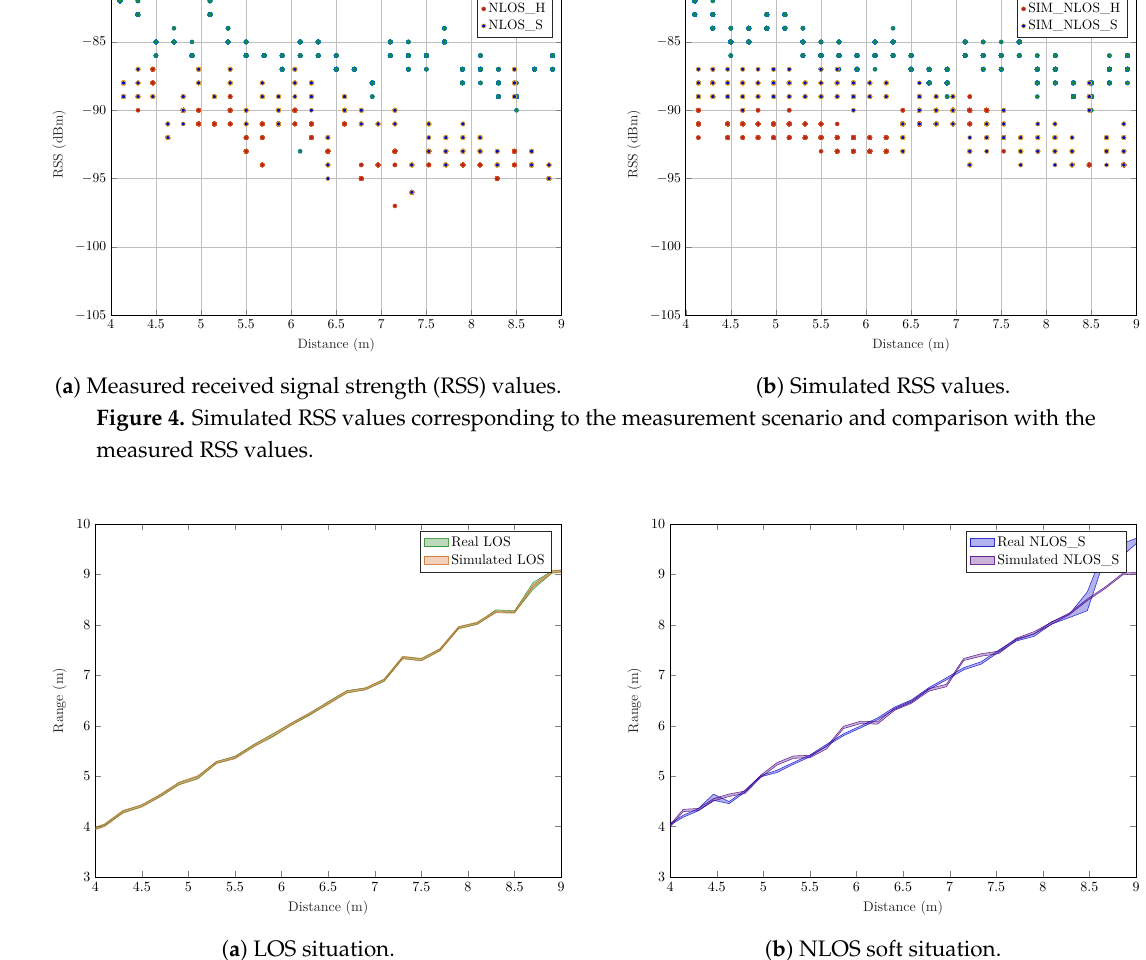
( b ) NLOS soft situation.